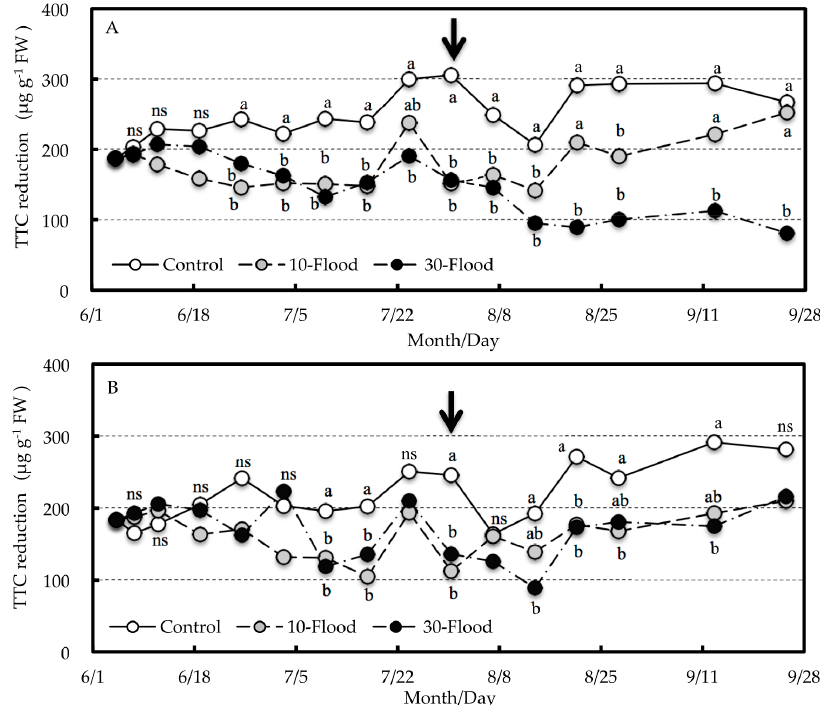
Figure 4. Changes in TTC reduction rate of roots in mango grafted trees ( A ) and seedlings ( B ) during and after treatments. Different letters in the figures indicate significant differences at p = 0.05 by Fisher’s LSD, and ns indicates no significant difference among the treatments ( n = 5). Arrow indicates the end of the treatments.